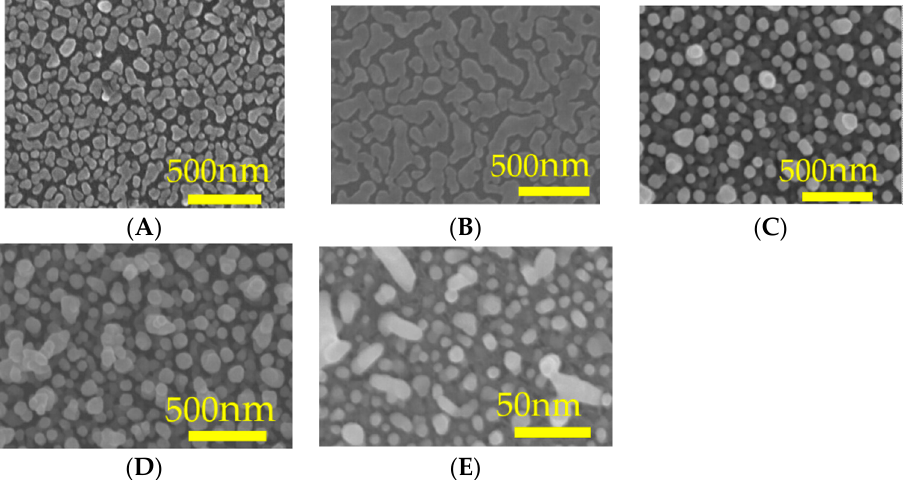
Figure 2. SEM images of Ag particles fabricated via electroless plating onto p-type c-Si wafers with AgNO 3 concentrations of ( A ) 0.0025M, ( B ) 0.005M, ( C ) 0.01M, ( D ) 0.015M and ( E ) 0.02M.